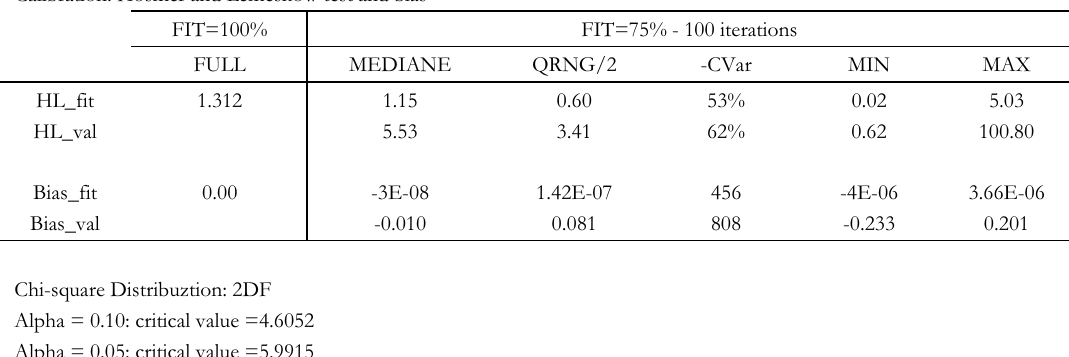
Calibration: Hosmer and Lemeshow test and